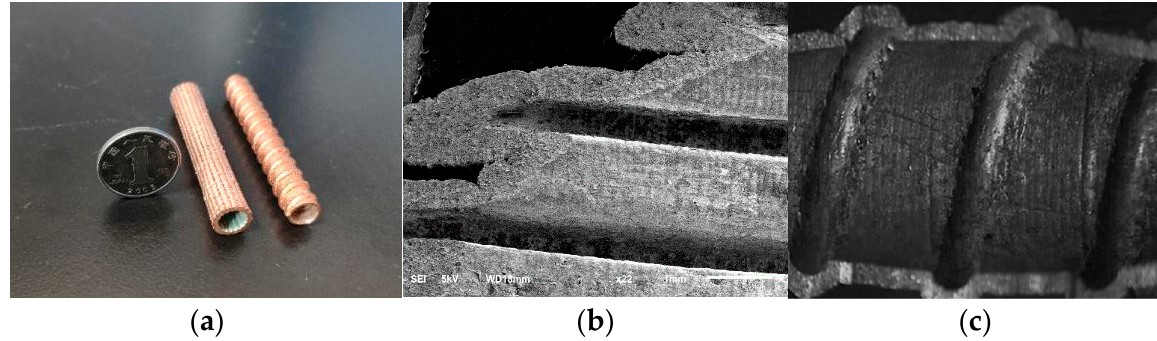
Figure 7. Microstructure of rotating inner wall prepared by electroforming. ( a ) The samples of the cathode, ( b ) The in- tenal morphology of one sample, ( c ) The internal morphology of the other sample.